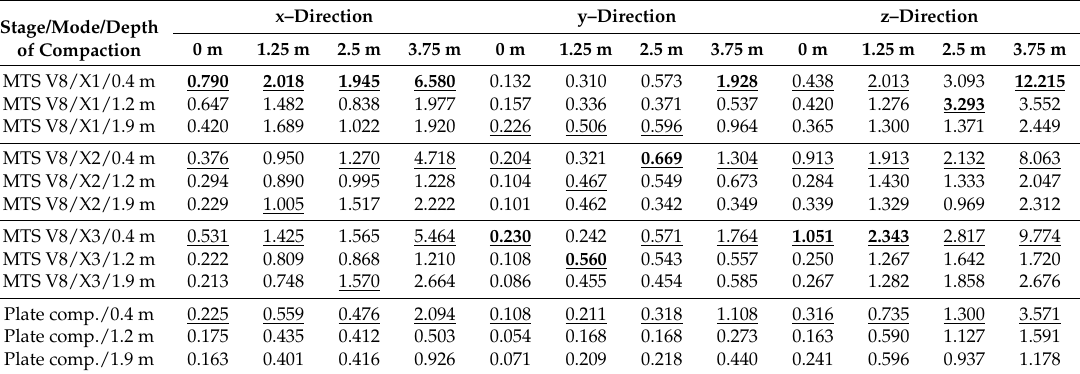
Table 4. Summary of PPAs—stage III (source of vibration Ls = 5 m), m/s 2